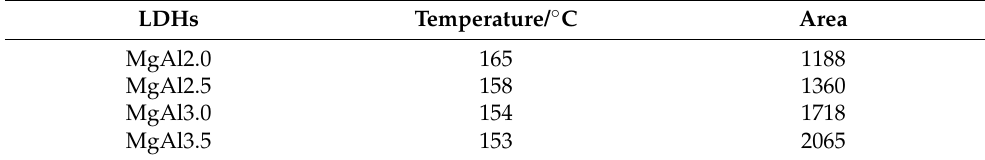
Table 2. Desorption peak temperature and area of LDHs with different Mg/Al molar ratios. LDHs Temperature/ ◦ C Area MgAl2.0 165